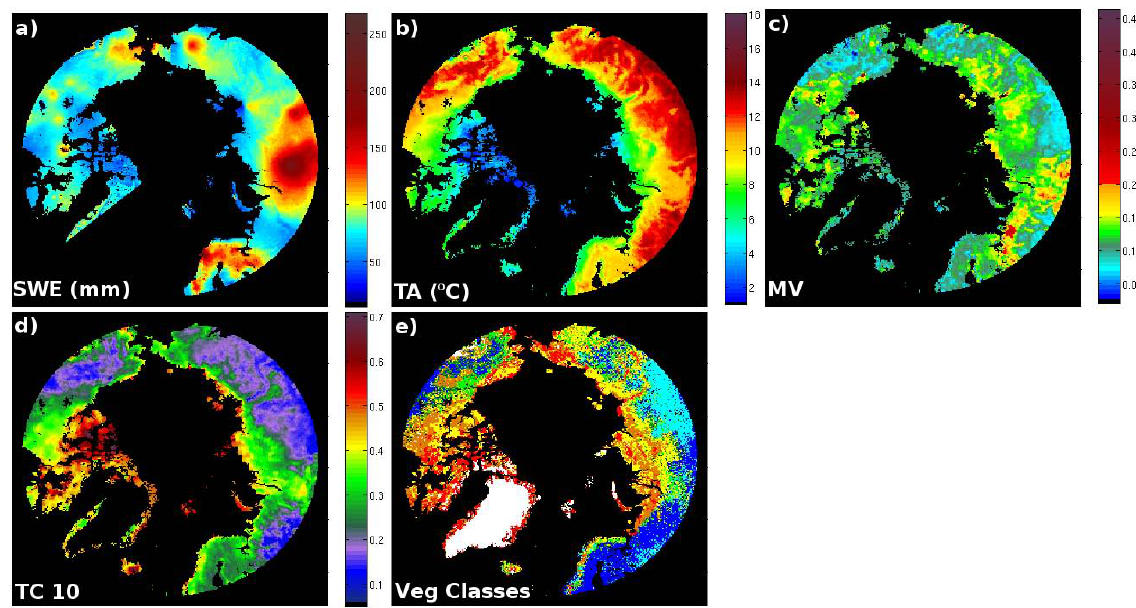
Fig. 3. Pan-Arctic (north of 60 ◦ ): (a) mean 2003–2008 snow season GlobSnow snow water equivalent (SWE); (b–d) mean 2003–2008 NTSG growing-season air temperature (TA), volumetric soil moisture at 2cm (MV), and vegetation transmissivity at 10.7GHz (TC10); and (e) vegetation classes used in this study, as described in Table